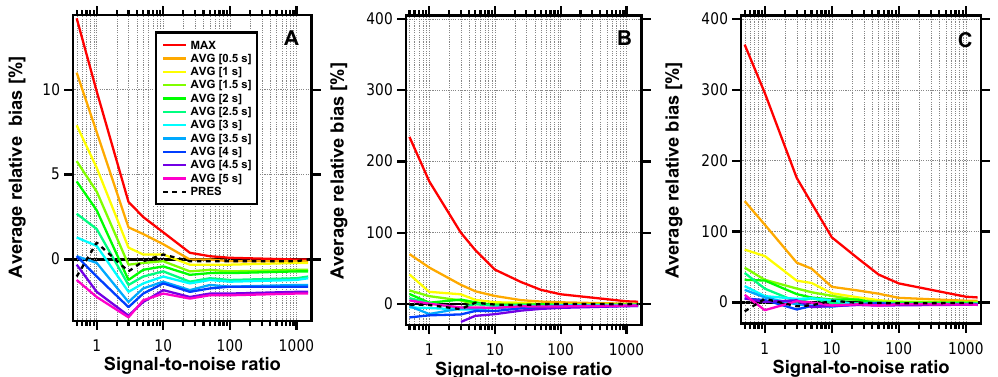
Figure 6. Panel (a) shows the average relative bias of a half-hourly flux as a function of the analyser signal-to-noise ratio for 31 days of 10Hz eddy-covariance sensible heat flux data acquired at a height of 32m. The signal-to-noise ratio of the temperature data was deteriorated to match predefined limits. The errors shown are relative to the sensible heat flux calculated using the unmodified temperature data and a constant (0s) time lag. Panels (b) and (c) show the same plot for disjunct eddy-covariance data with sampling intervals of 2.5 and 7.5sm